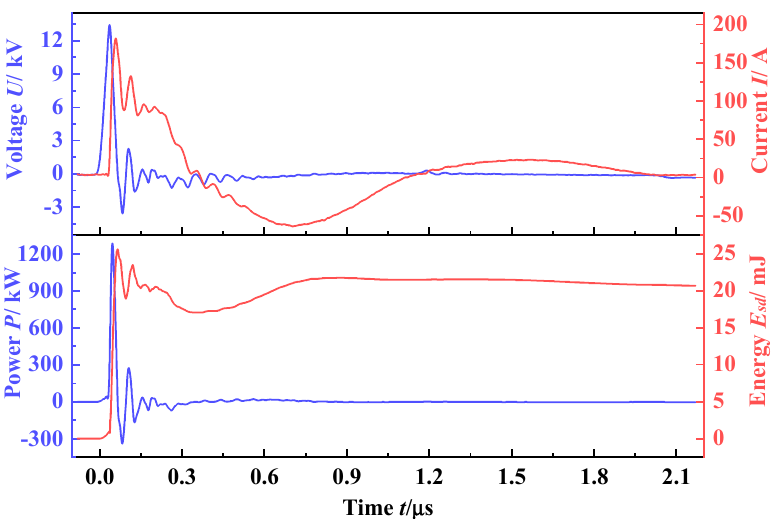
Figure 2. Typical nanosecond discharge waveforms of voltage, current, power and energy for a single discharge, parameters set at 15 kV, 100 ns and 10 kHz.